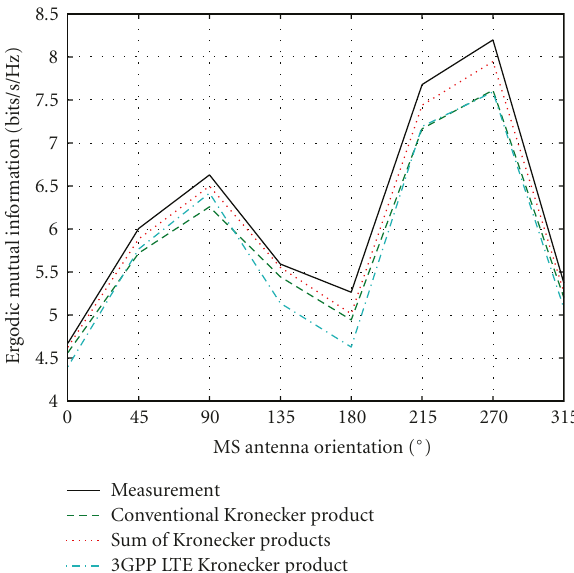
Figure 10: Ergodic mutual information at MS8 of the Laptop scenario.